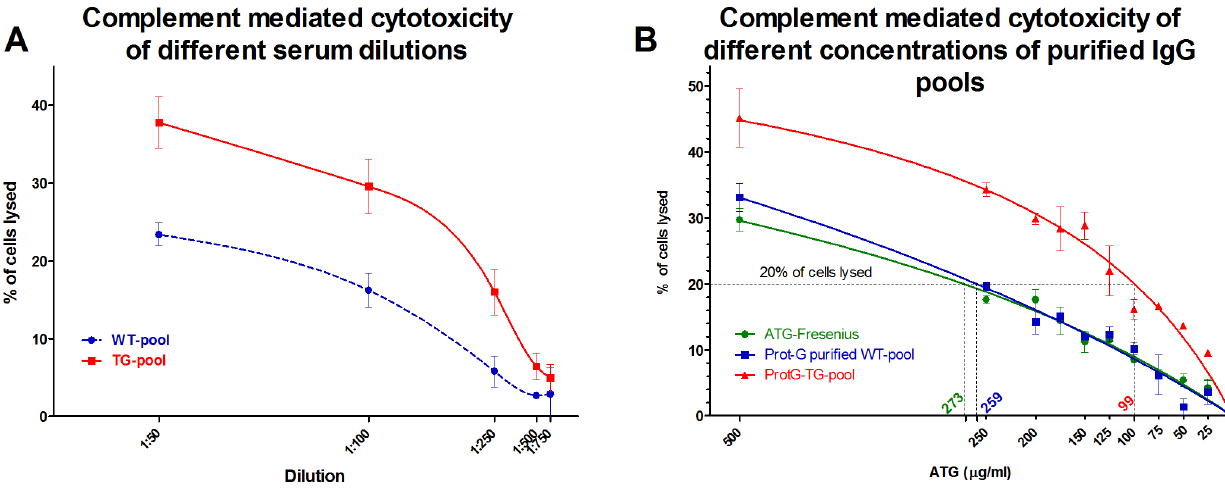
Figure 4. Complement activated cytotoxicity of rATG from Tg and wt rabbits. A. Complement activated cytotoxicity of pooled immune serum samples collected from wt and Tg rabbits on day 21 of immunization. Tg-pool of immune sera was more efficient in killing Jurkat cells at all dilutions. B. Concentration dependent induction of complement activated cytotoxicity by protein-G purified IgG collected on day 21 of immunization from wt and Tg rabbits (ATG-Fresenius S IgG was used as reference). We observed more efficient cytotoxicity of the Tg samples at all concentrations, and when cytotoxicity curves were analyzed with non-linear regression analysis, data showed that 20% cytotoxic activity was achieved by adding 259 m g/ml, 273 m g/ml or 99 m g/ml IgG preparations from the wt IgG, ATG-Fresenius or Tg IgG preparations, respectively, indicating that Tg IgG mediated cytotoxicity was more than 260% more efficient than its wt control. Percent of lysed cells was determined by flow cytometry analyzing propidium iodide incorporation (samples were analyzed in triplicate and error bars indicate standard deviations of these